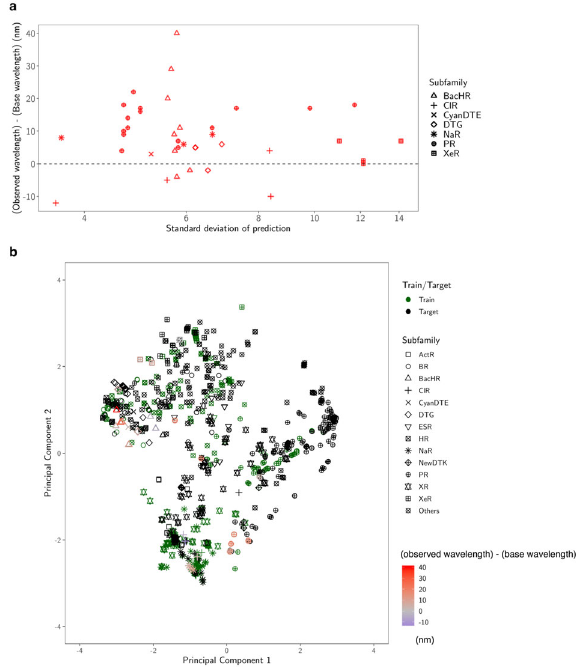
Fig. 7 Diversity of the selected proteins. a Predicted standard deviation (horizontal axis) vs. observed gain (vertical axis). The marker shape represents the subfamily of each protein. b Two-dimensional projection created by principal component analysis. The original d = 432 dimensional feature space is projected onto the fi rst two principal component directions. The fi rst component (horizontal axis) explains 33% of the total variance of the original space, and the second (vertical axis) explains 17%. The green markers are the training data, and the black markers are the target data. For the synthesized proteins, differences in the observed and base wavelengths are shown by the color map. The results indicate that, by considering the exploration – exploitation trade-off, it was possible to make a red-shift protein screening process that considered not only the expected value of the prediction, but also the uncertainty.